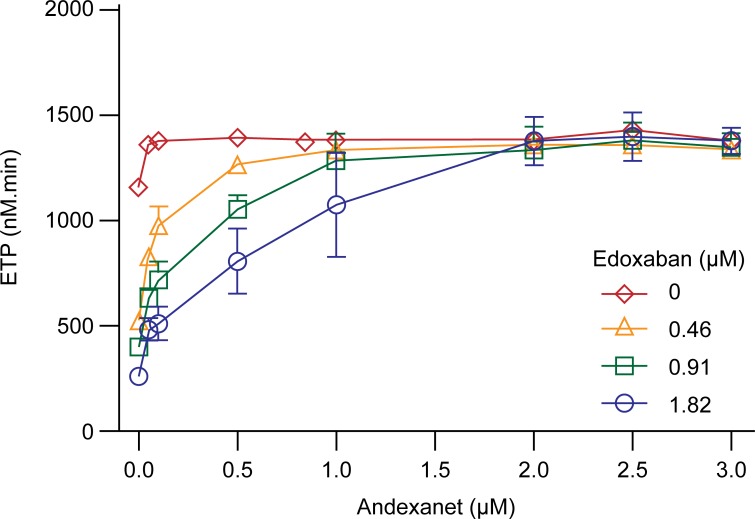
In vitro reversal of edoxaban-induced inhibition of thrombin generation in human plasma.Plasma samples contained edoxaban at 0 (◇), 250 (△), 500 (□), and 1000 (○) ng/mL (0, 0.46, 0.91, 1.82 μM) and increasing concentrations of andexanet (0, 0.05, 0.1, 0.5, 1.0, 2.0, 2.5, 3.0 μM). Data (ETP) were plotted as mean ± standard deviation from two separate experiments. Additional thrombin generation parameters are provided in S2 Fig.